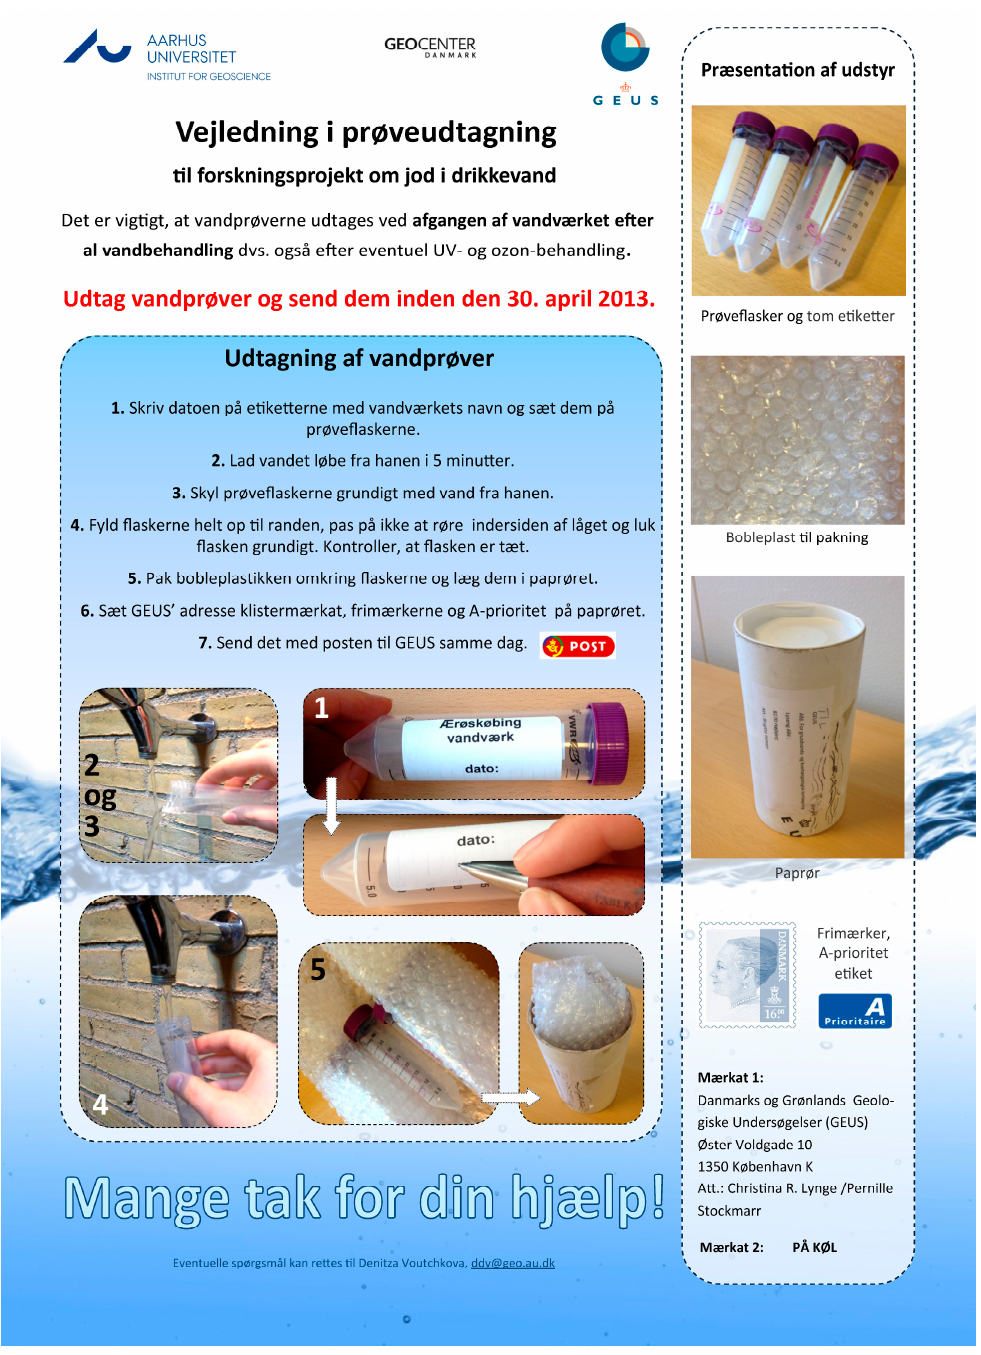
Figure A1. Manual for drinking water sampling sent to the participating waterworks (in Danish only); for translation see Box A1.